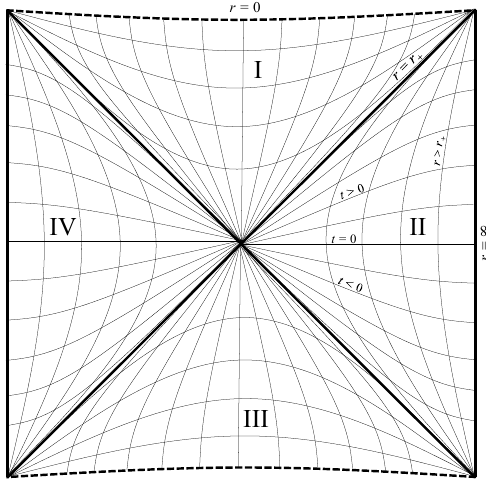
Figure 1 . Penrose diagram of the static black hole solution with (cid:22) > 0, namely r + > 0 > r (cid:0) . where t 2 R , (cid:30) 2 [0 ; 2 (cid:25) ] with period 2 (cid:25) , and r 2 R